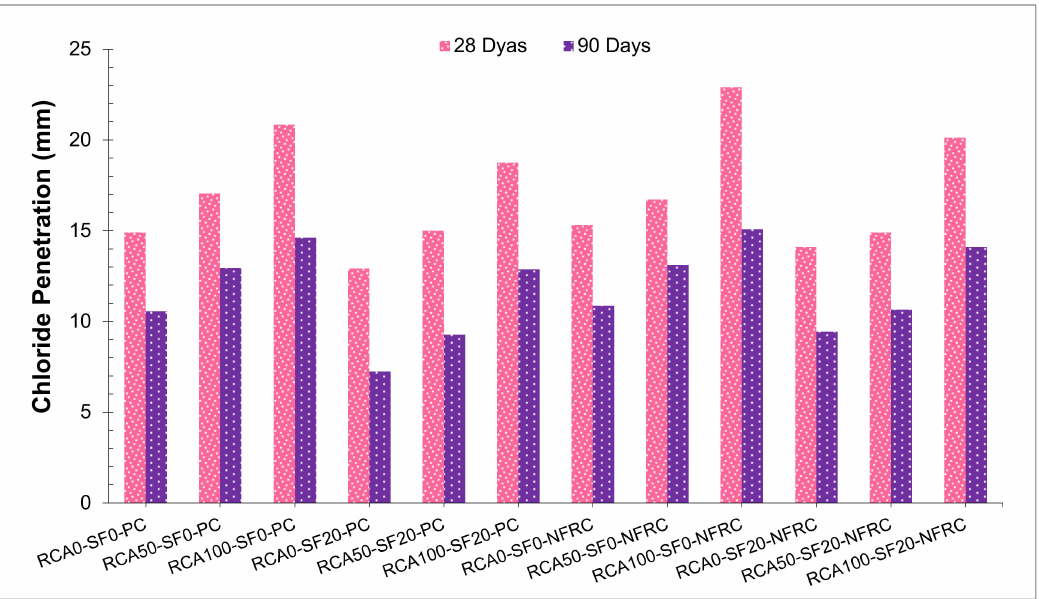
Figure 9. Chloride Penetration of Concrete